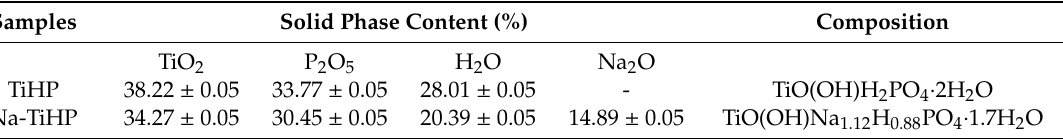
Table 1. Elemental analysis data for titanium phosphate products.